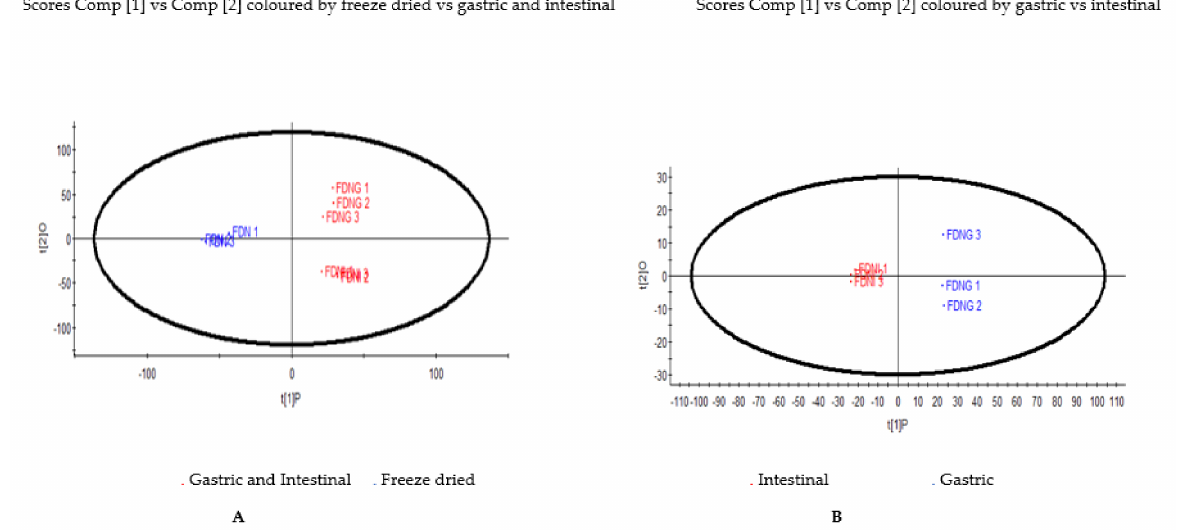
Figure 1. ( A ): Score plot of principal component analysis (unsupervised) based on UPLC–Q-TOF/MS spectra of the Natal plum freeze-dried fruit powder during simulated gastrointestinal digestion. Two cluster groups showing FDN on the left-hand side, and FDNG and FDNI on the right-hand side. ( B ): Score plot of principal component analysis (unsupervised) of the Natal plum freeze-dried fruit powder in the gastric and intestinal fraction. FDN: Freeze-dried Natal plum, FDNG: Freeze-dried Natal plum in the gastric fraction; FDNI: Freeze-dried Natal plum in the intestinal